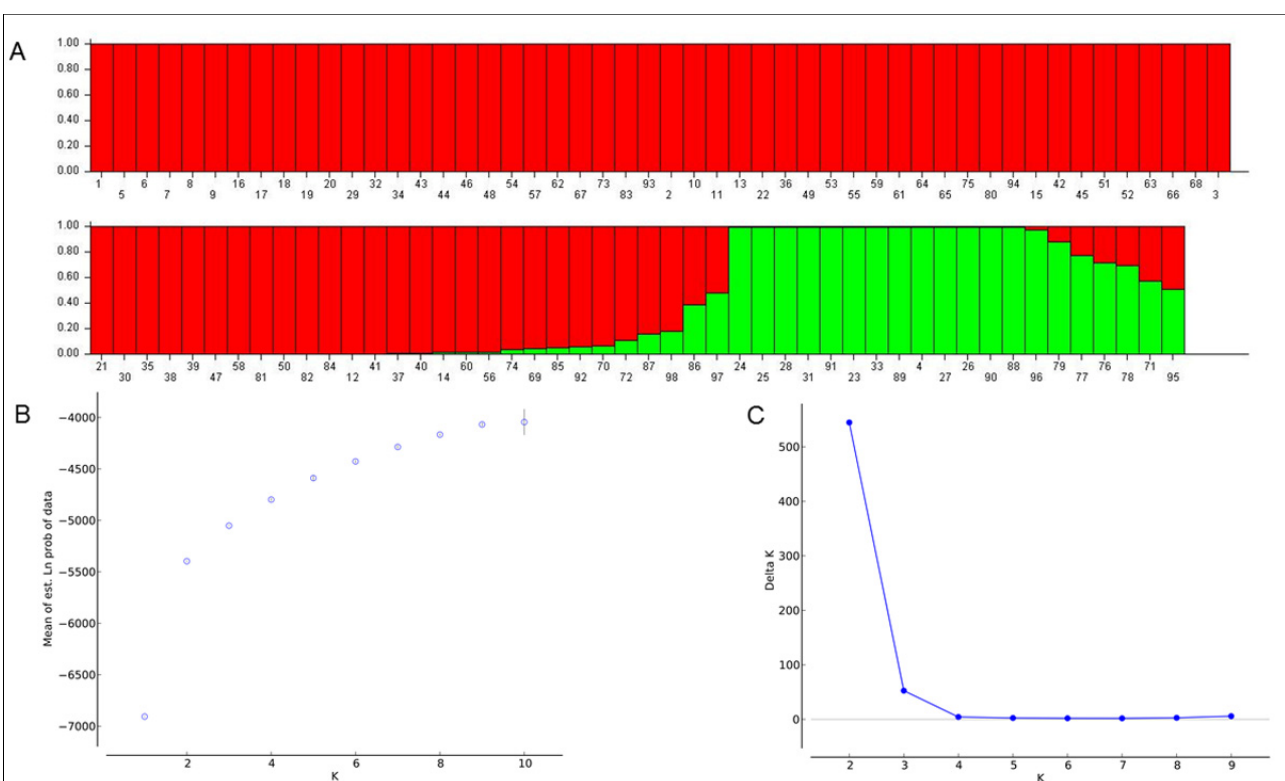
Figure 4. Population structure analysis of 98 rice accessions using STRUCTURE 2.3.4. ( A ) Classification of the 98 accessions into two subgroups (K = 2), ( B ) the average of log-likelihood value, and ( C ) delta K values for different numbers of populations assumed (K).